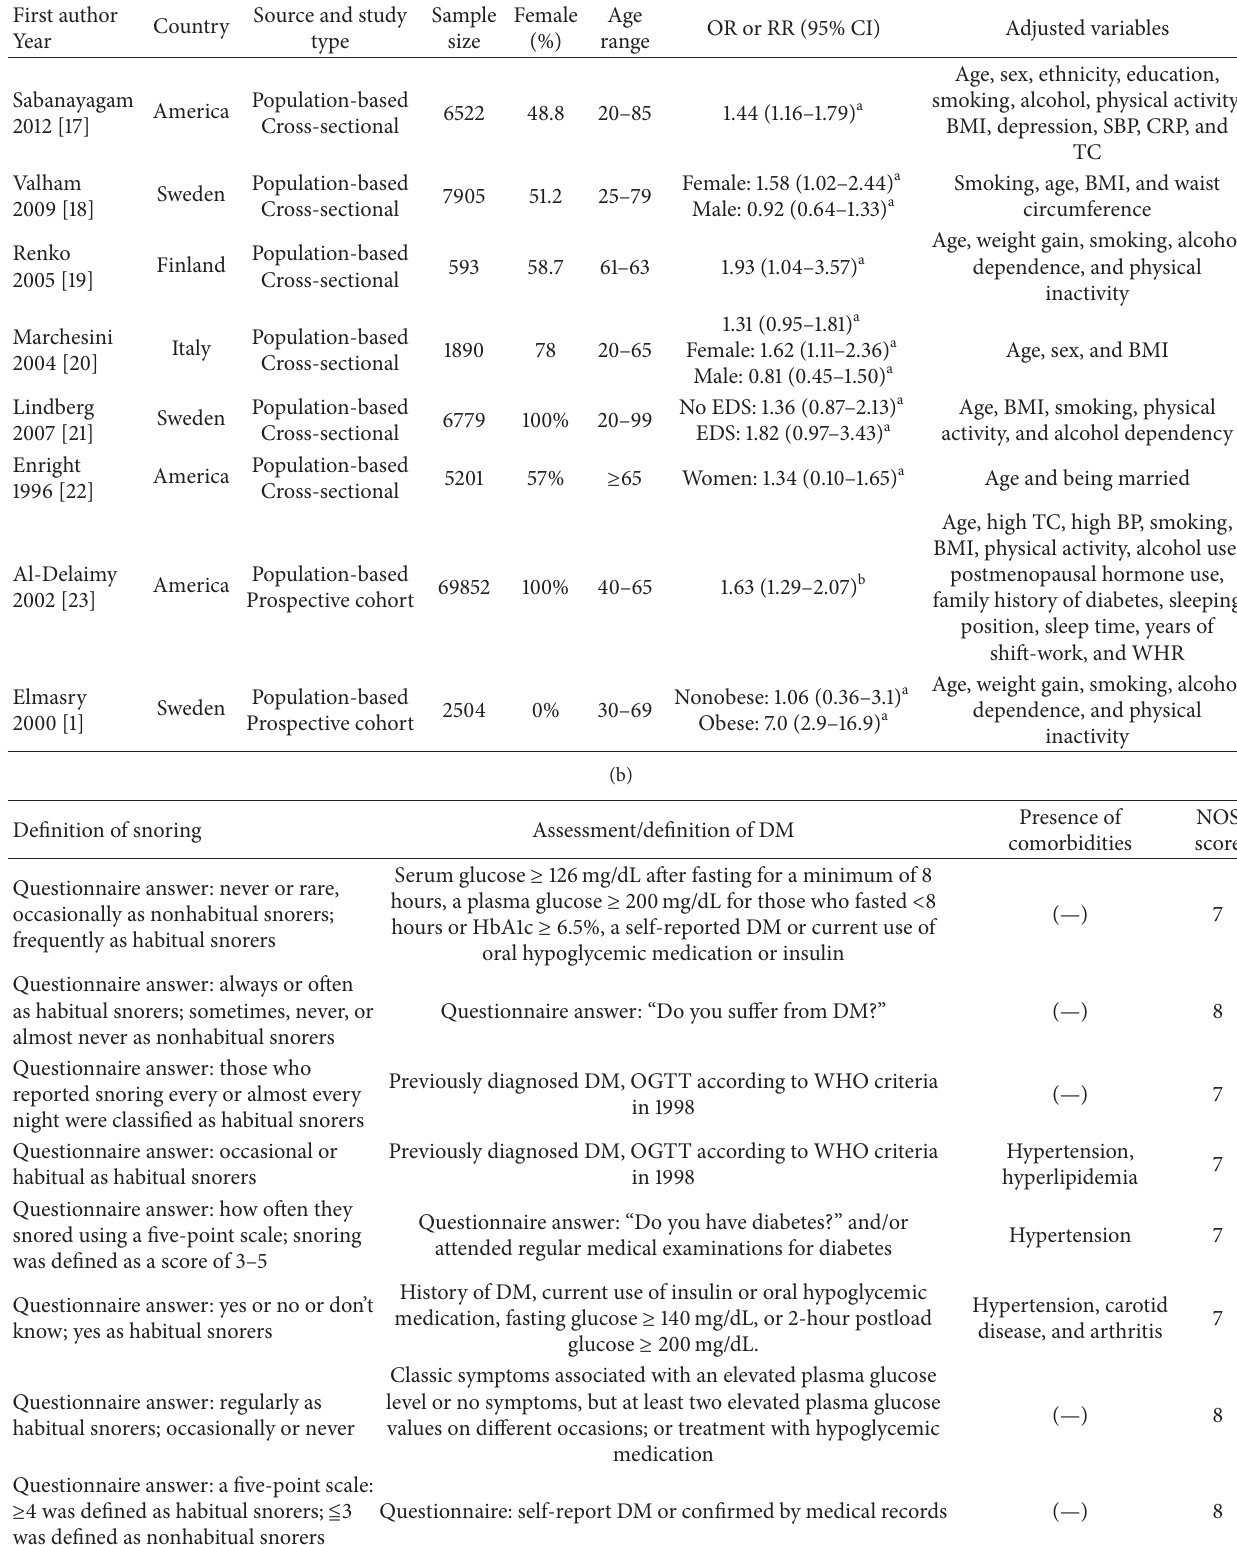
Table 1: Characteristics of included studies in this